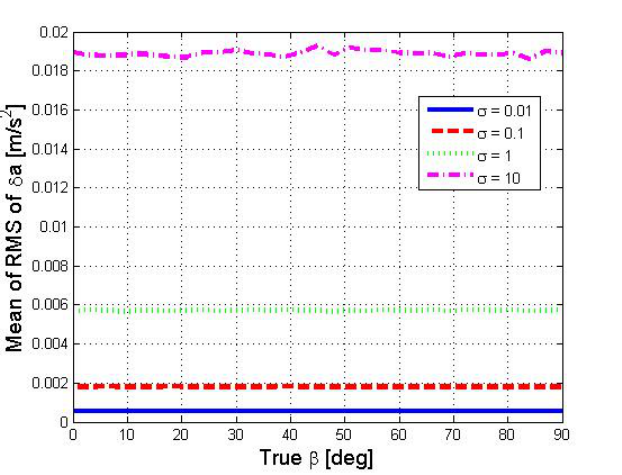
Figure 6. Average of the RMS of δ a p as a function of γ h . Curves represent different accelerometers’ (cid:112) ( noise variance σ in units of µ g/ Hr ) . The inner plot zooms in an area of interest in the